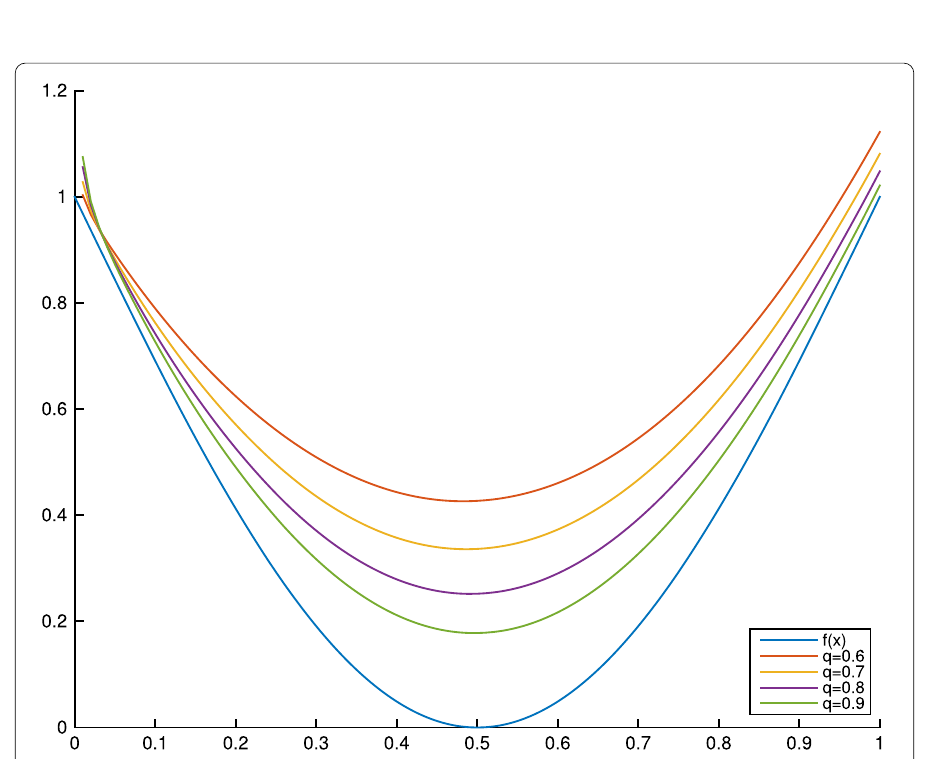
Figure 4 Monotonicity of T n , q , α ( f ; x ) in the parameter